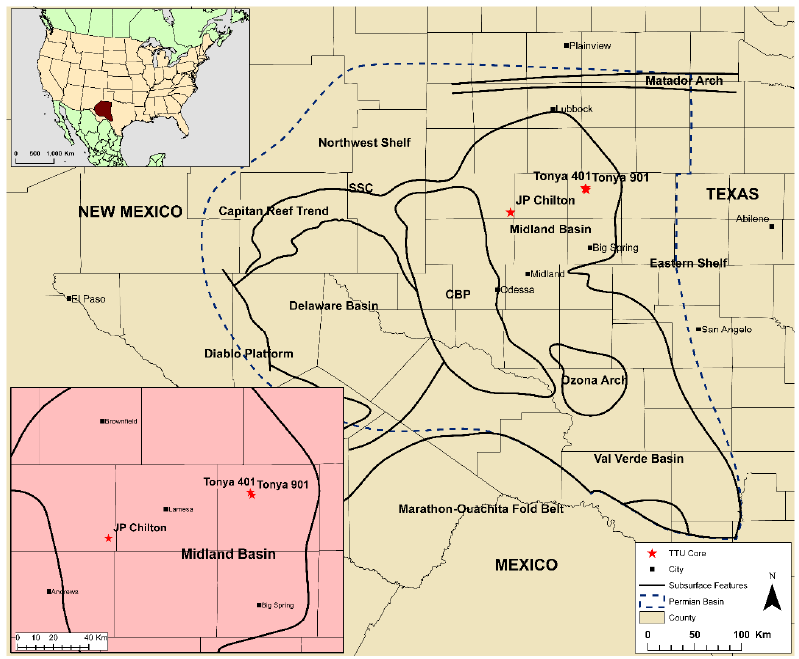
Figure 1. Geographic location of the Greater Permian Basin region with associated subsurface basins. The cored samples are denoted by the red stars within the northern Midland